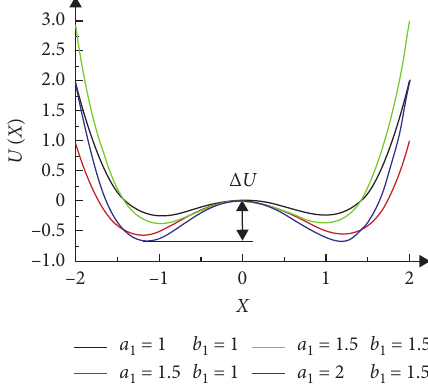
Figure 3: Barriers for different well